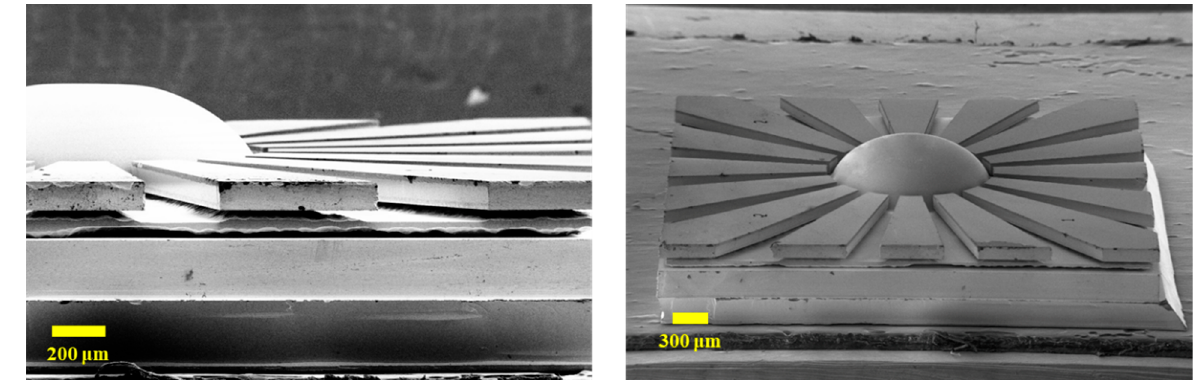
Figure 7. SEM pictures of the eave-shaped structure.